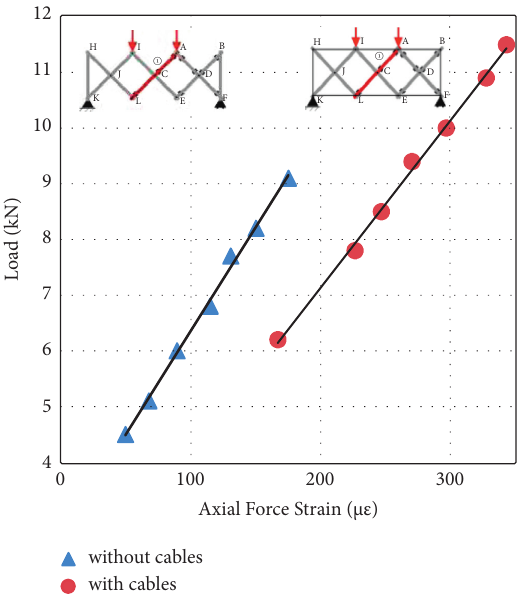
Figure 16: Comparison of the load-axial strain of structures with and without steel cables.